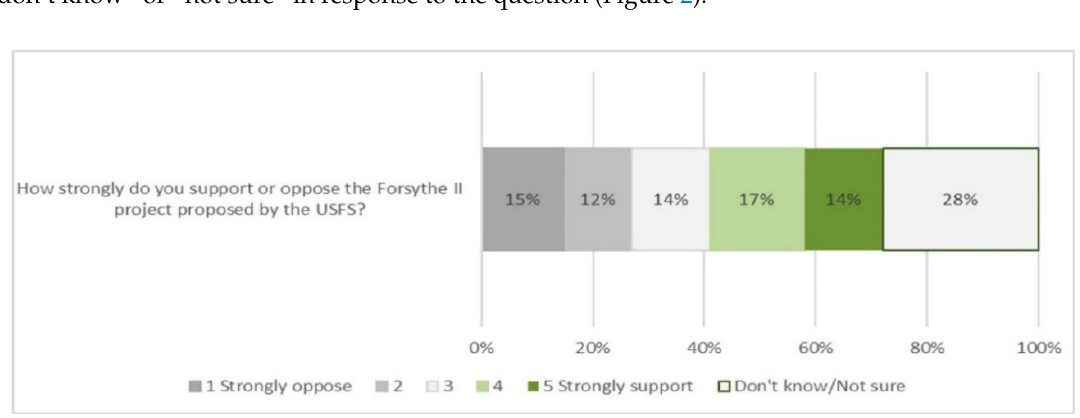
Figure 2. Forsythe II support among survey respondents.